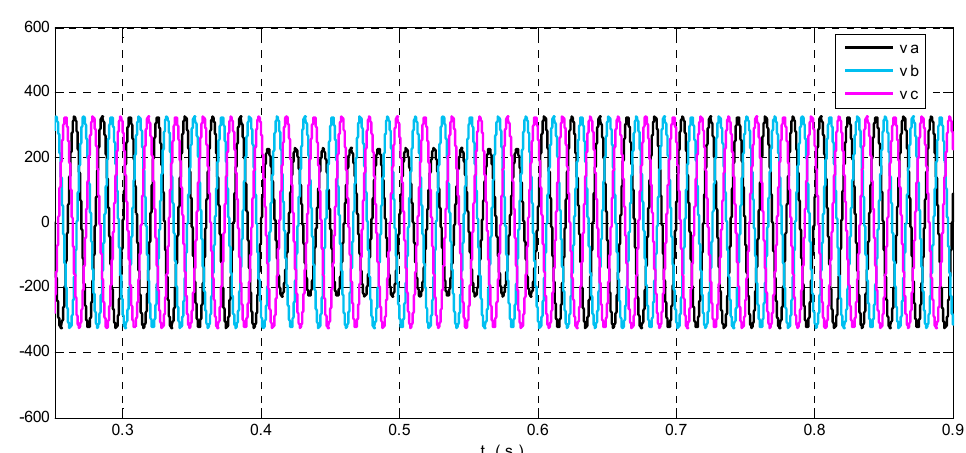
Figure 19. The grid voltage signals.